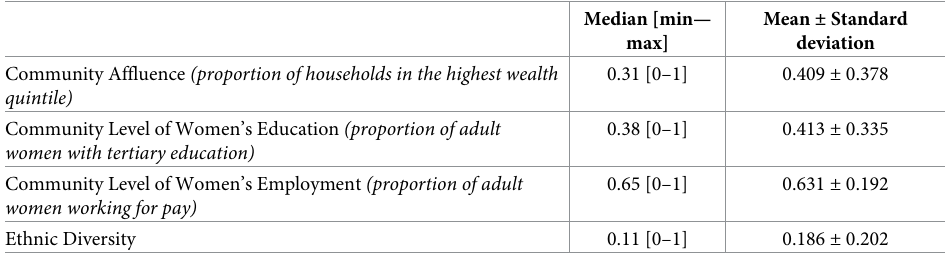
Table 2. Distribution of adolescent girls in the sample by community characteristics.